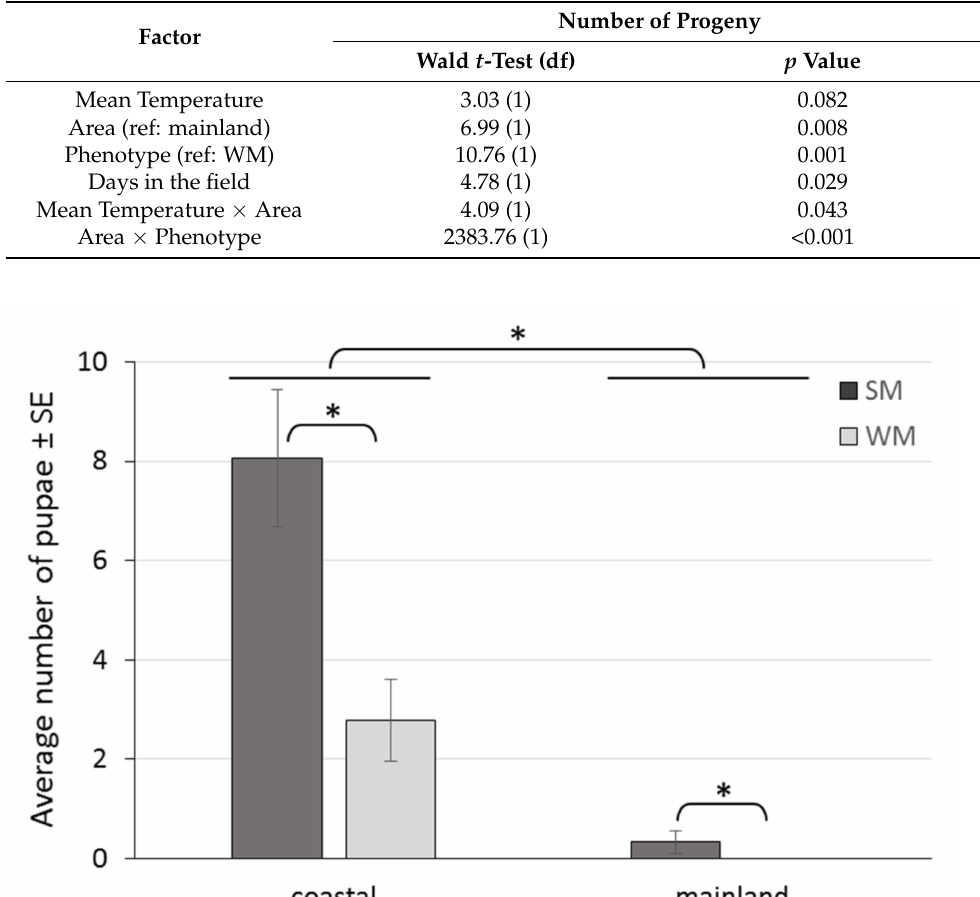
Table 3. Variables of the generalized estimating equations GEEs with significant effects on the progeny production by Drosophila suzukii females in the two areas tested.